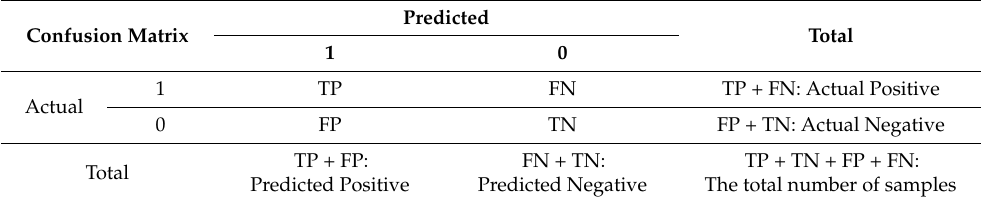
Table 13. Confusion